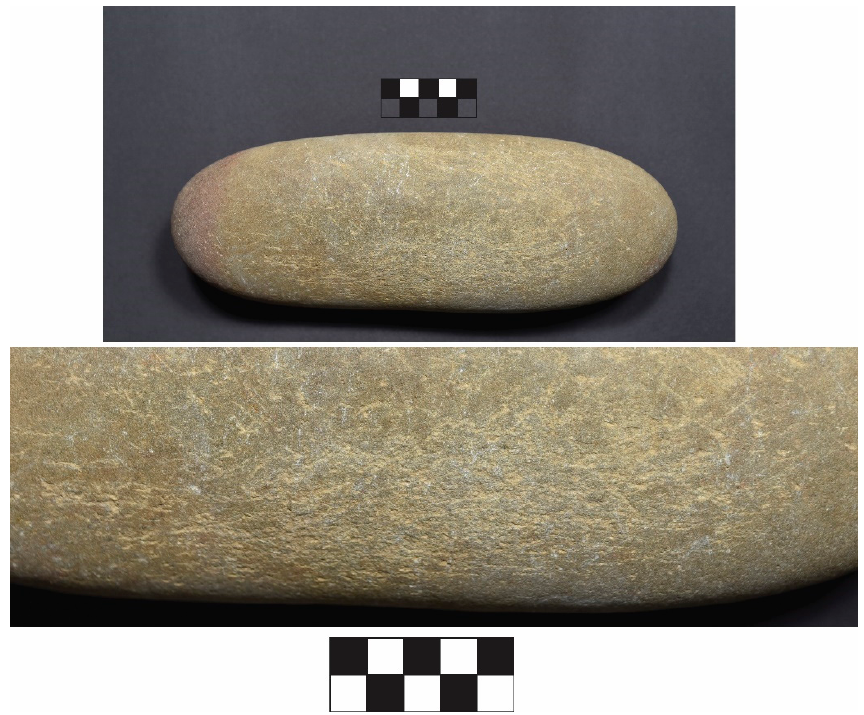
Figure 7. RHBF hammer (2016SGT2019 ⑦ 109).